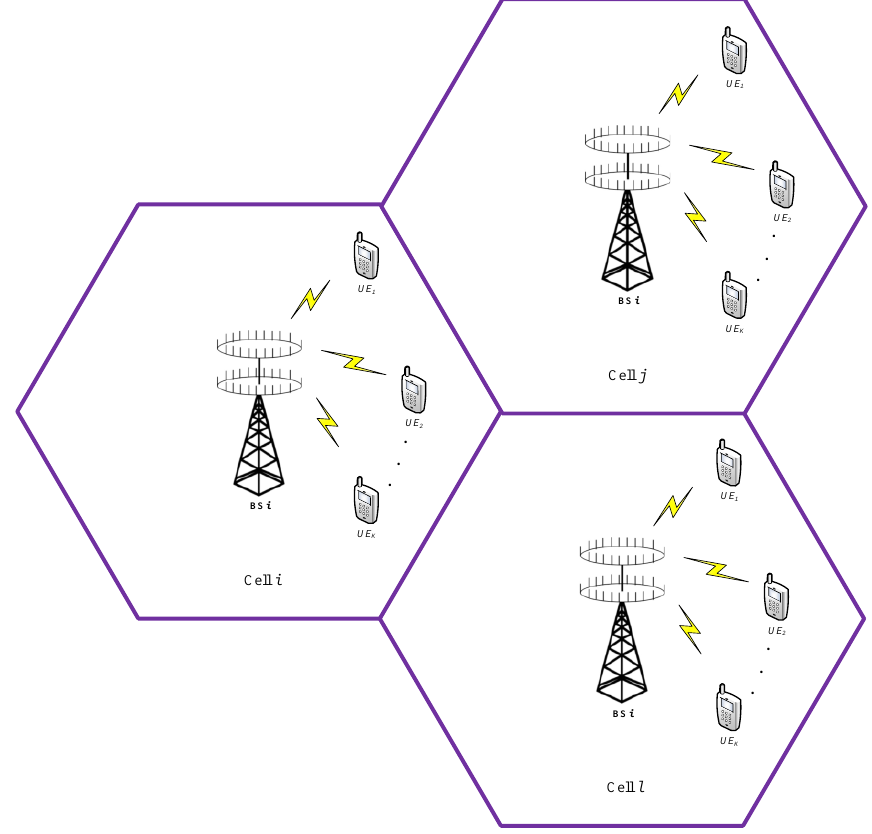
Figure 1. Massive multiple-input multiple-output system model.